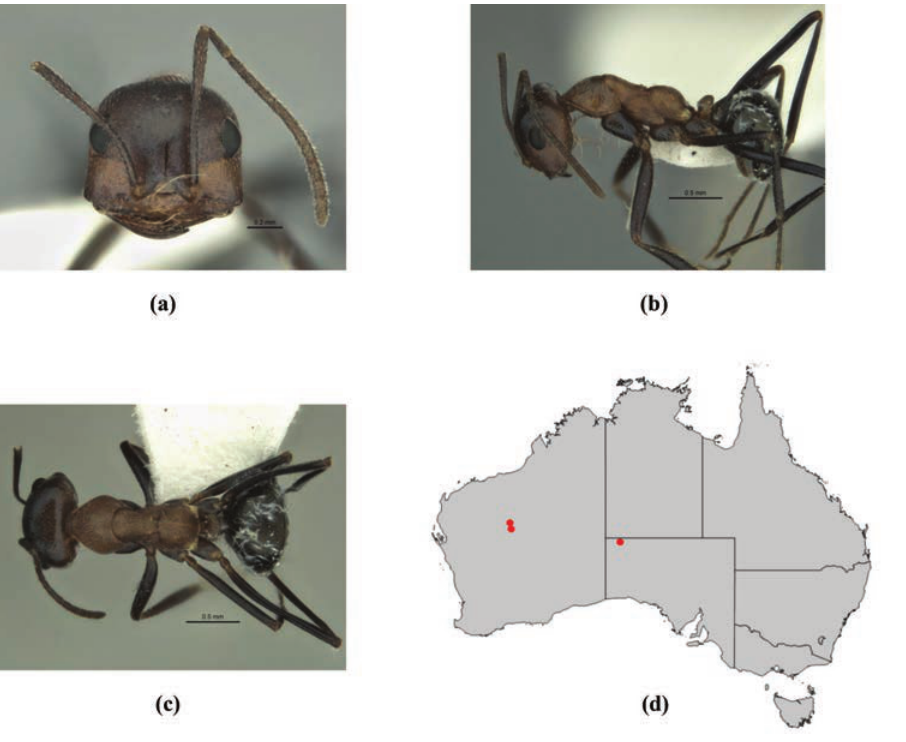
Figure 88. Melophorus xouthos sp. n.: holotype minor worker (ANIC32-900211) frons ( a ), profile ( b ) and dorsum ( c ); distribution map for the species ( d ). Low resolution scale bars: 0.5 mm ( b, c ); 0.2 mm ( a slightly smaller than tooth no. 4 but much smaller than tooth no. 2 in two specimens seen; masticatory margin of mandibles strongly oblique. Mesosoma . Integument of pronotum, mesonotum and mesopleuron matt or with a weak sheen and shagreenate throughout; anterior mesosoma in profile weakly elevated anteriad, thereafter gently sinuate, pronotum and mesonotum on same plane; erect pronotal setae absent; in pro- file, metanotal groove a weak or vestigial furrow; propodeum matt or with a weak sheen and indistinctly shagreenate; propodeum smoothly rounded or with indistinct angle; length ratio of propodeal dorsum to its declivity not applicable, propodeal dorsum and declivity confluent; erect propodeal setae always absent; appressed propodeal setulae long, each reaching setae behind and in front, but not forming pubescence; propodeal spiracle situated on or beside declivitous face of propodeum, and shorter (length < 0.50 × height of propodeum). Petiole . In profile, petiolar node narrowly rectangular, vertex blunt, directed posteriad; in full-face view, node tapered with blunt vertex; node matt with indistinct microsculpture. Gaster . Gaster weakly shining, shagreenate (‘LP record’ appearance); pilosity of first gastral tergite consisting of well-spaced, long, whit- ish, appressed setae with occasional erect non-marginal setae present in at least some workers, as well as a few marginal setae on the first gastral sclerite. General characters .